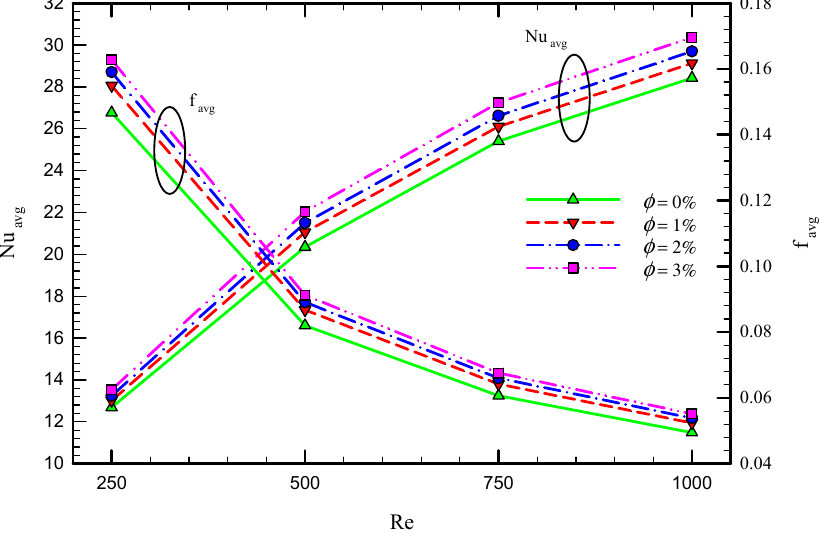
Figure 16. Variation of average Nu number and friction coefficient for Case 5 at different Re numbers and nanofluid volume concentrations.